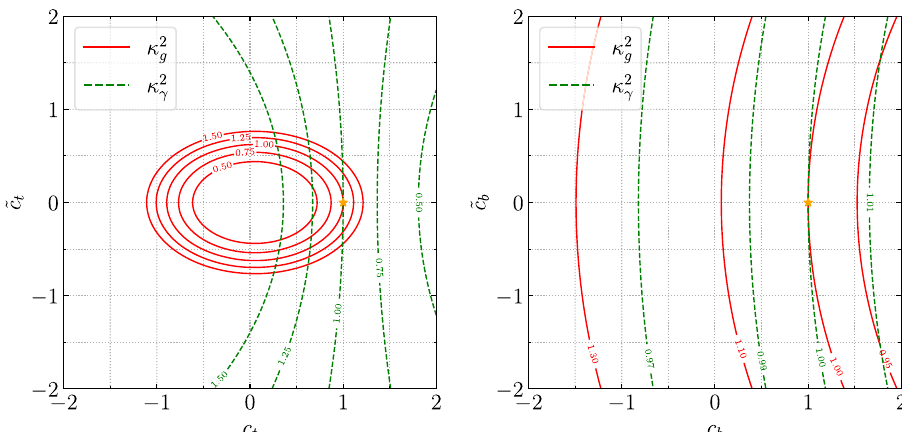
Fig. 1 κ 2 g and κ 2 γ as a function of (left) c t and ˜ c t and (right) c b and ˜ c b , with all other parameters fixed to their SM values. The orange star denotes the SM